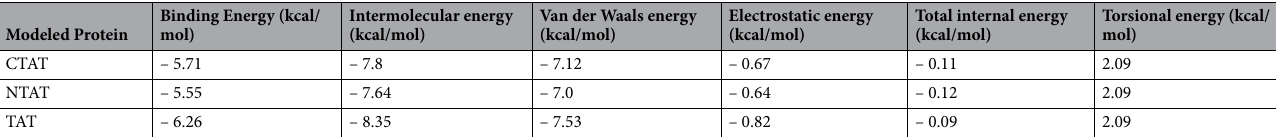
Table 1. Binding free calculation of NTAT, CTAT and TAT obtained by docking PLP co-factor in Autodock